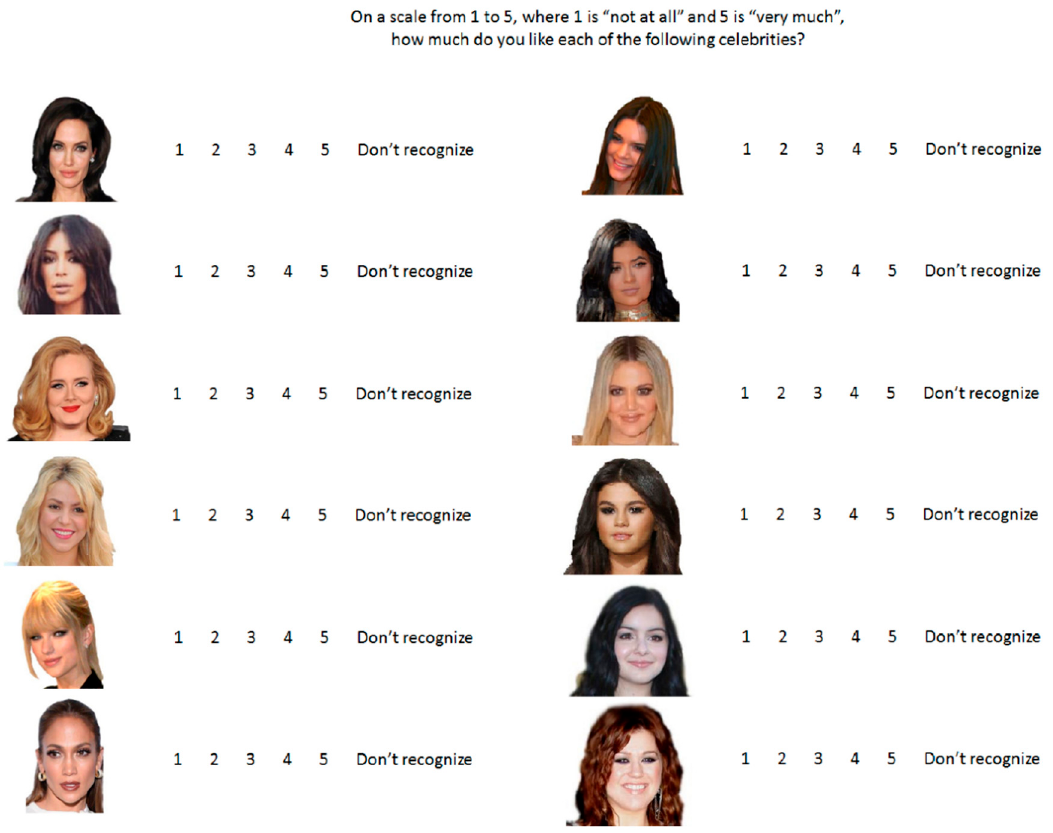
Figure A5. Celebrity Liking and Recognition.